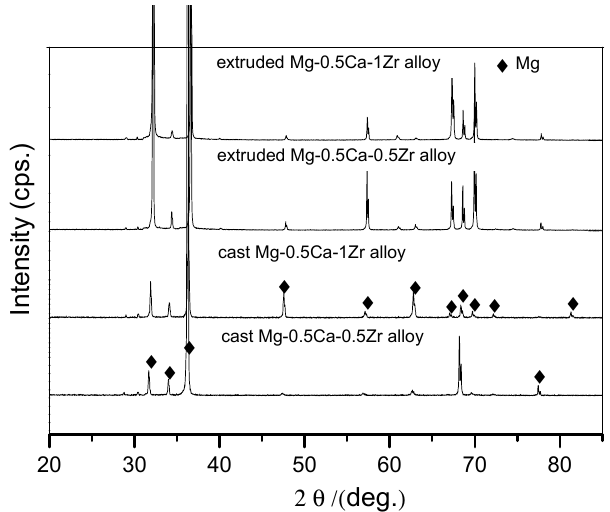
Figure 2. XRD patterns of as-cast and extruded Mg alloys.